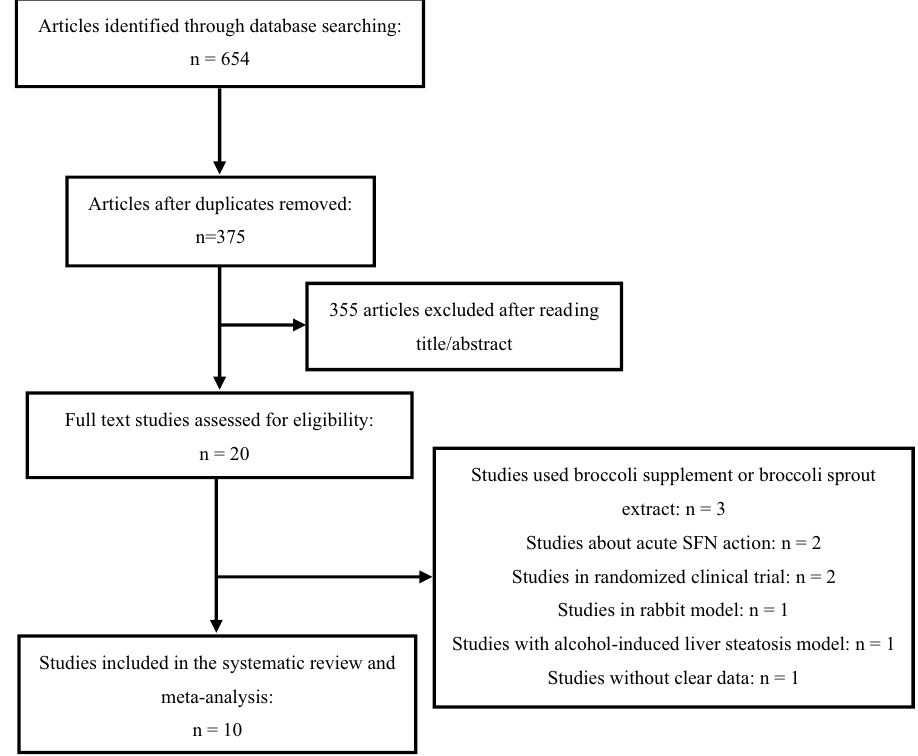
Figure 1. Flow diagram of database searches and study